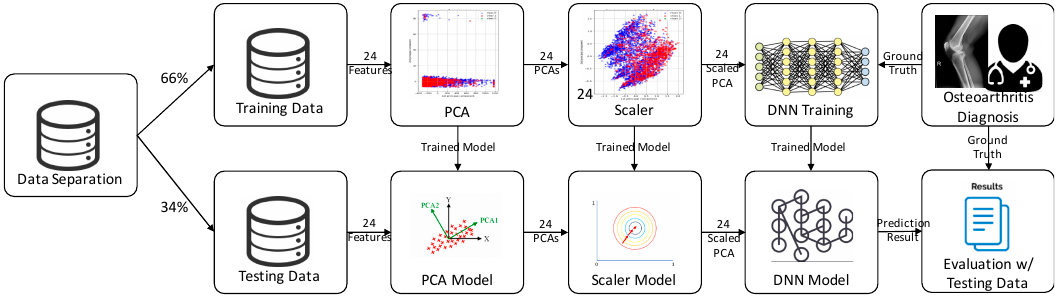
Figure 2. The proposed system architecture of the deep neural network (DNN) with scaled principal component analysis (PCA).